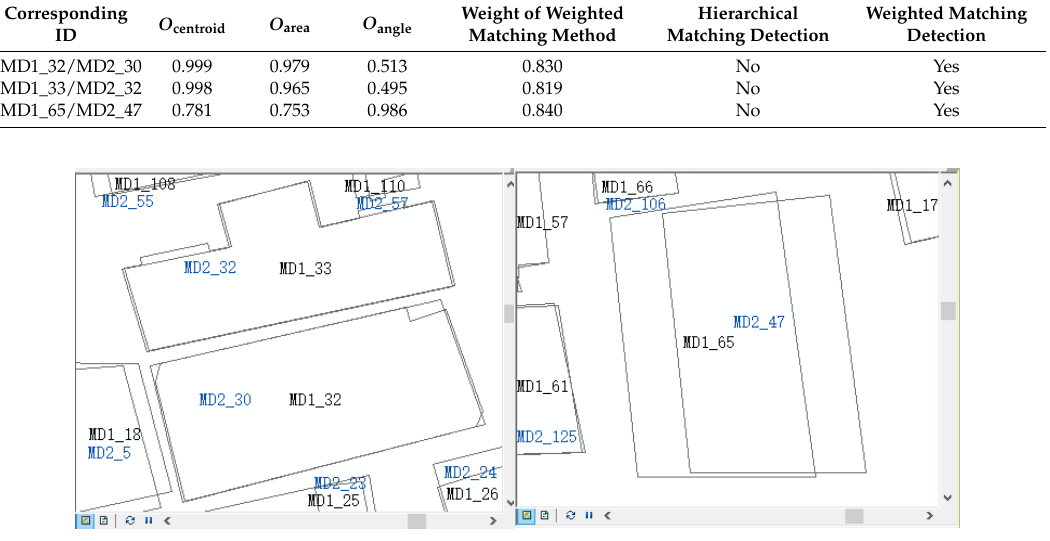
Figure 5. Case comparison of matching objects from hierarchical matching and weighted algorithm. Table 3. Matching analysis of object instances. Table 4. Matching results in different study areas.